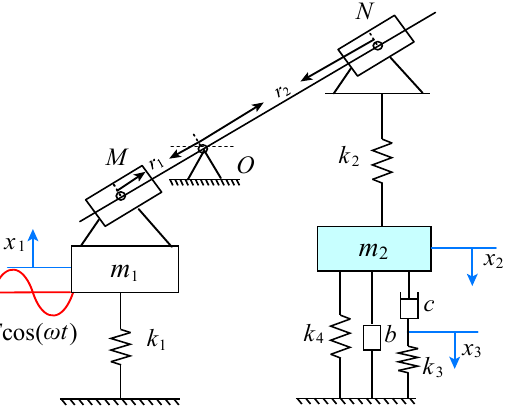
Figure 1. The viscoelastic Maxwell-type DVA model with lever, inerter, and grounded